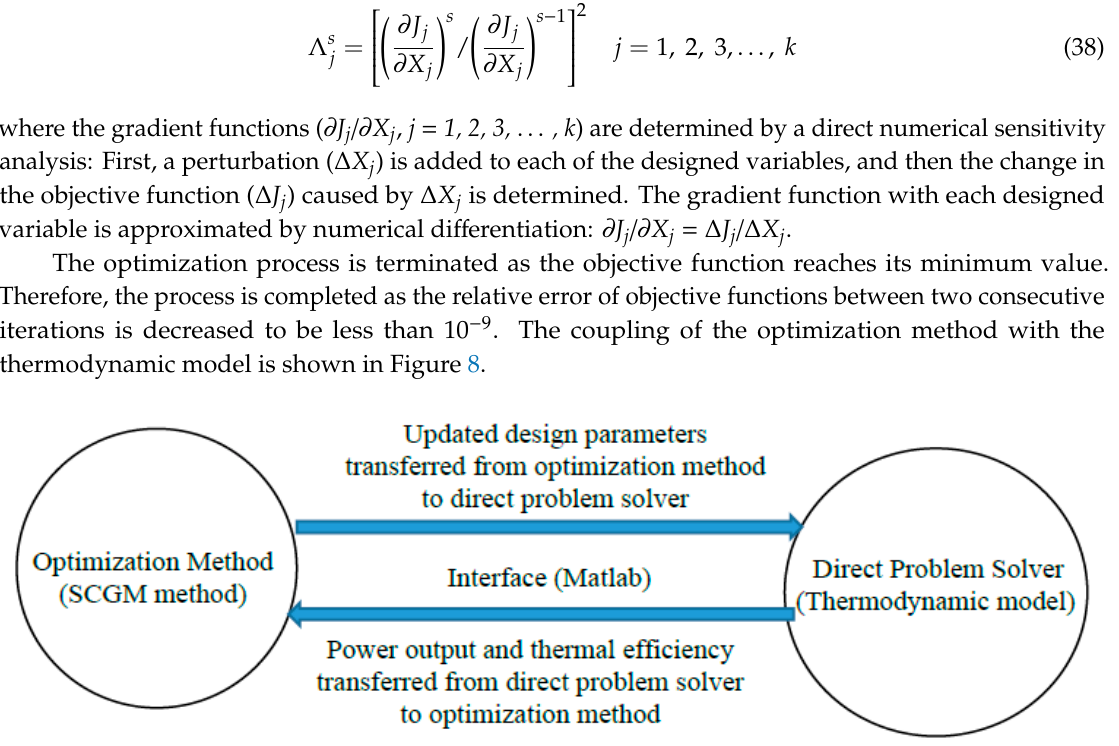
Figure 8. Connection between optimization method and thermodynamic model.